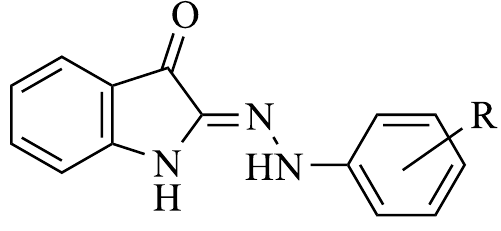
Fig. 6. Isatin derivatives as anticonvulsant activity (Emami et al.,